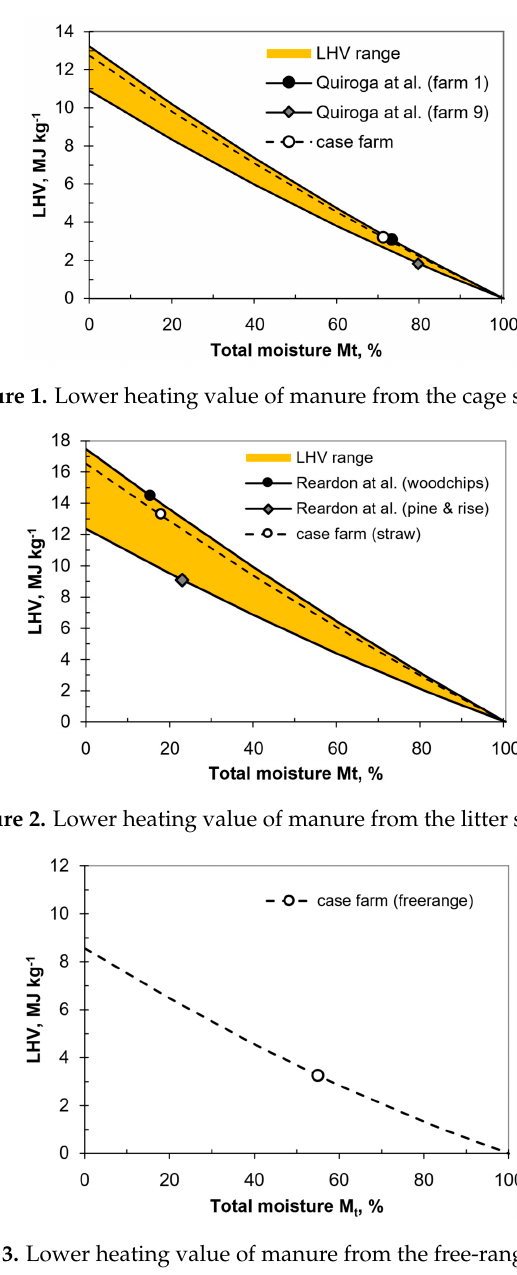
Figure 3. Lower heating value of manure from the free-range system.